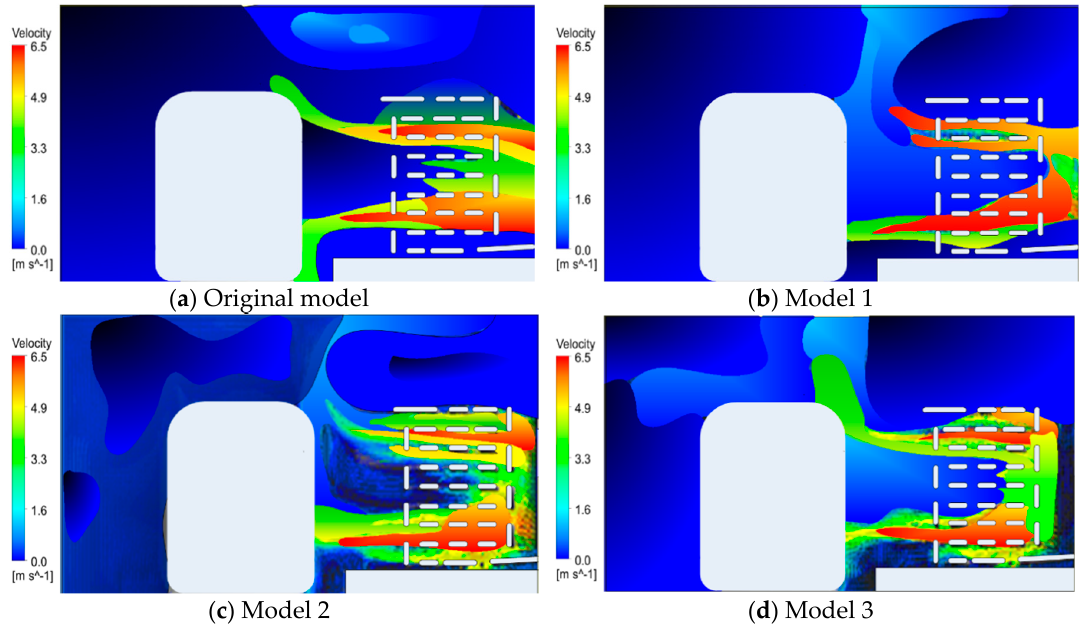
Figure 15. Velocity plots of vertical section at + 40 mm position from the center—front view.